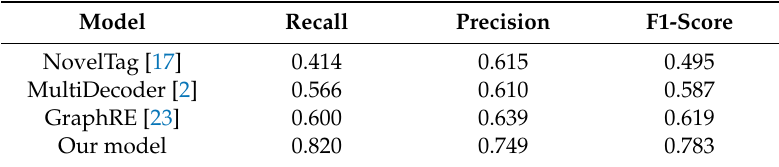
Table 7. Performance comparisons on the NYT corpus.